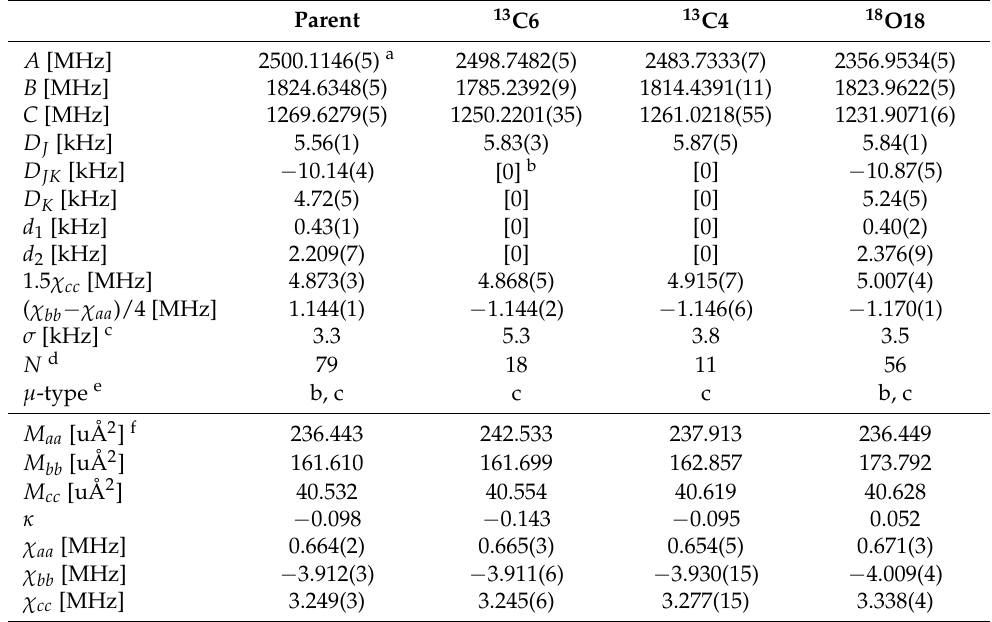
Table 2. Experimental spectroscopic parameters of DEHA-W in the S -reduction and III l -representation.